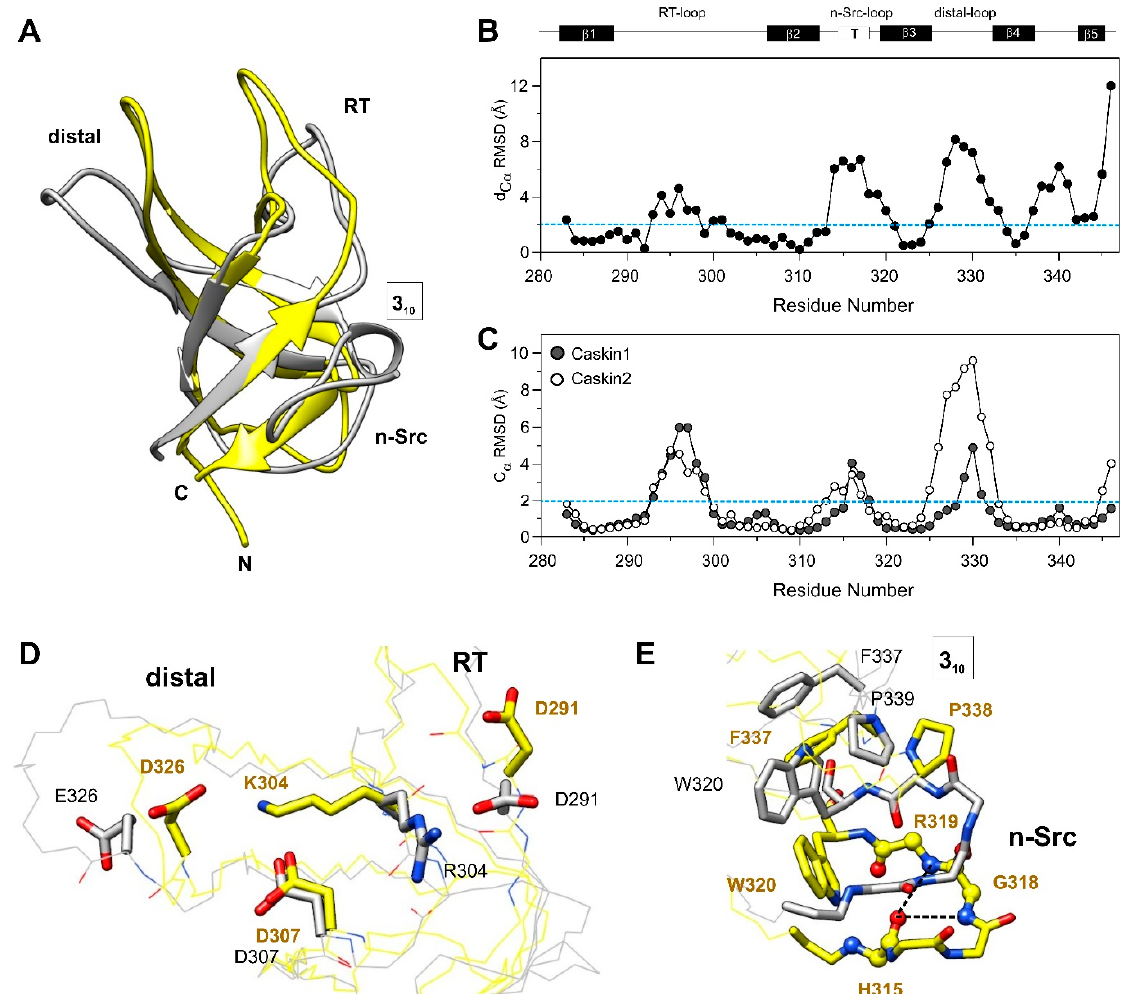
Figure 6. Structural comparison of the SH3 domains of human Caskin1 and Caskin2. ( A ) Superimposed ribbon diagrams of the lowest-energy element of the structural ensemble of the SH3 domains of human Caskin1 (yellow, PDB: 7ATY) and Caskin2 (grey, PDB: 2KE9 [18]). ( B ) C α positional differences between the mean structures of the Caskin1 and Caskin2 SH3 structural ensemble. ( C ) Average C α RMSDs based on pairwise distances between matched atoms in the lowest-energy structural ensemble of the SH3 domain of human Caskin1 (grey) and Caskin2 (white). Dashed lines in ( B ) and ( C ) at 2 Å are for better viewing. ( D , E ) Superimposed diagrams of the Caskin1 (yellow) and Caskin2 (grey) SH3 domains highlighting ( D ) stabilizing electrostatic interactions between the RT- (K304) and the distal-loops (D326) and ( E ) the formation of a type I turn in the n-Src-loop of Caskin1. Stabilizing H-bonds between the backbone atoms of H315, G318, and R319 are indicated by dashed lines. Hydrophobic interactions of W320 with F337 and P339 of the 3 10 -helical region in Caskin2 SH3 are shown in grey. Nitrogen and oxygen atoms are shown in blue and red, respectively. See text for details.